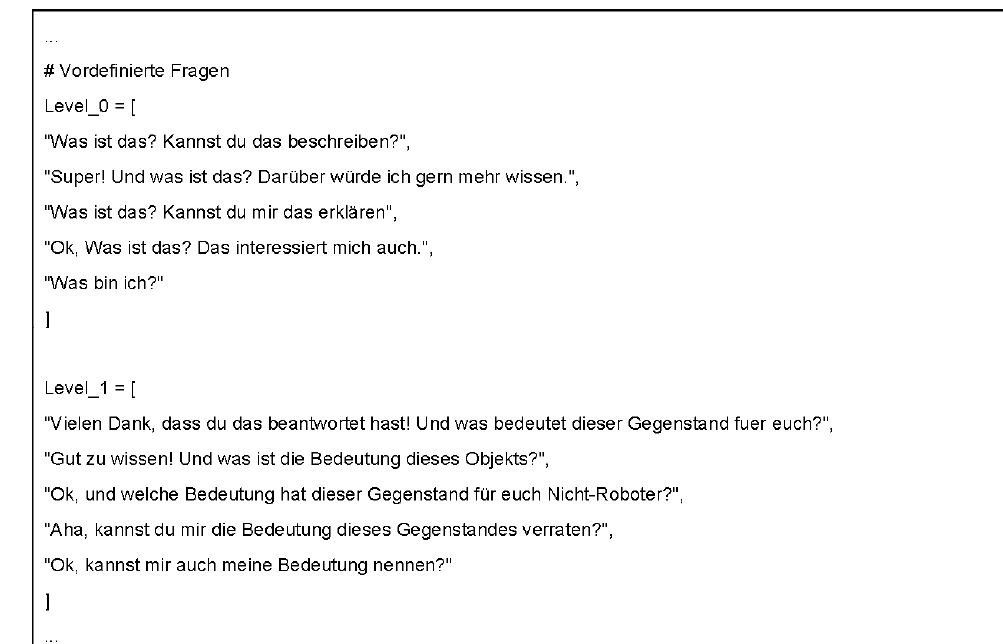
Figure 5. Excerpt of variations of the humanoid robot dialogue (Examples of questions). Technologies 2017 , 5 , 6